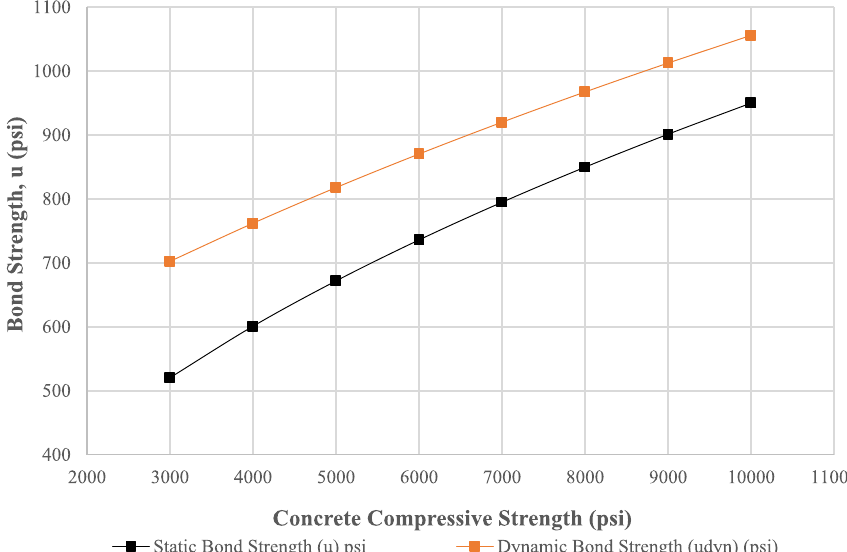
Fig. 8 Bond strength at increasing compressive